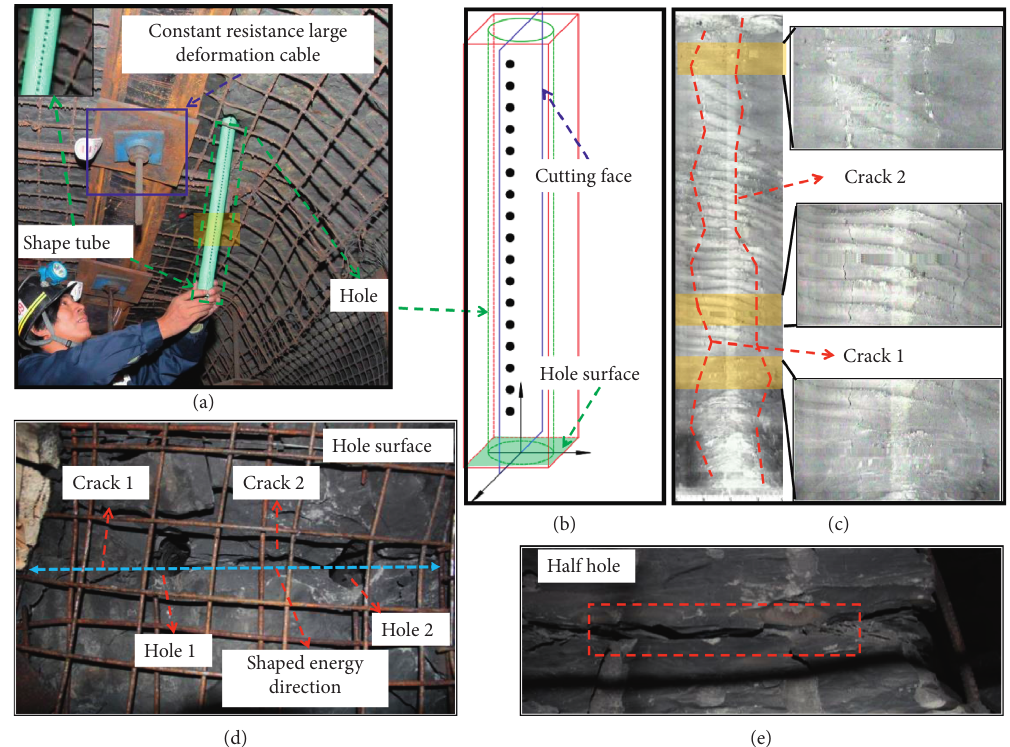
Figure 19: Crack propagation after shaped energy blasting. (a) Construction drawing of the shape tube installed before the shaped energy blasting. (b) Schematic diagram after the shape tube installed in the hole. (c) Diagram of the crack propagation of the cohesive direction of the gun hole after the shaped energy blasting. (d) Through cracks between the adjacent holes after the shaped energy blasting [22]. (e) Falling rock along the precrack surface after advanced Figure 18. The diameter of the hole was 48 mm, the diameter of the shaped tube was 36 mm, the diameter of the drug roll was 32 mm, and the uncoupling coefficient of the charging structure was 1.5.